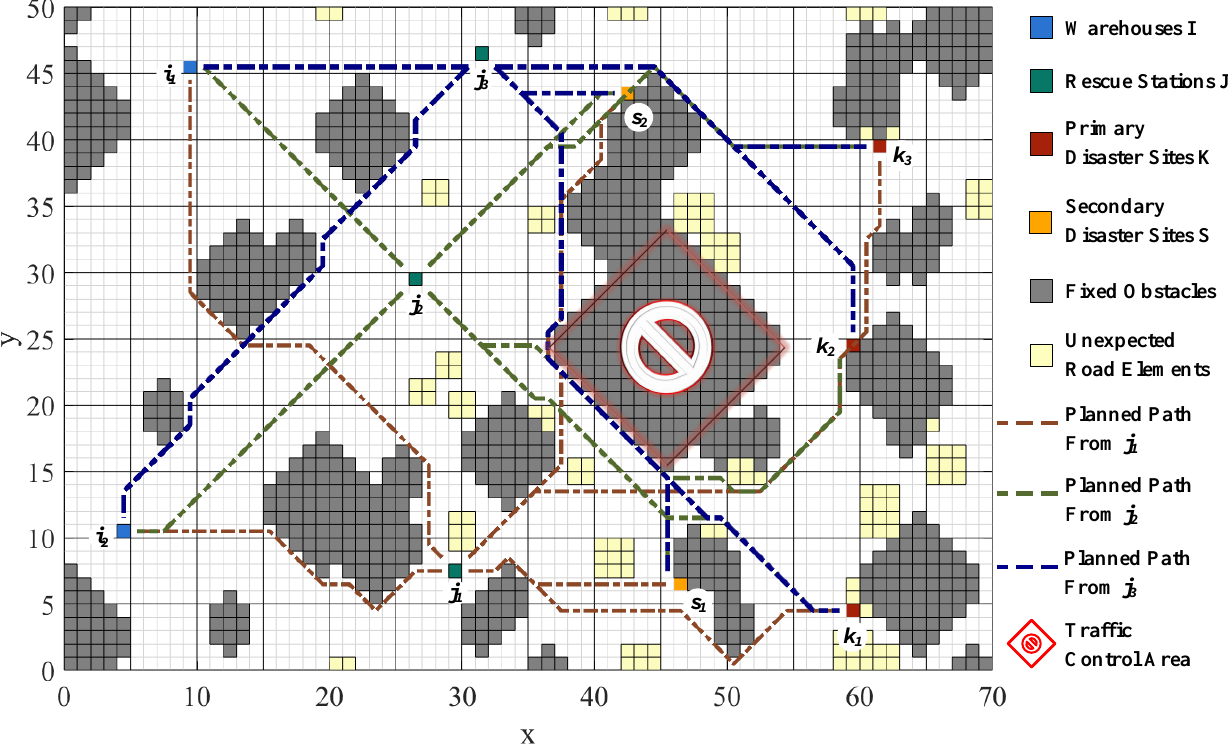
Figure 7. Detours when the key transportation hub